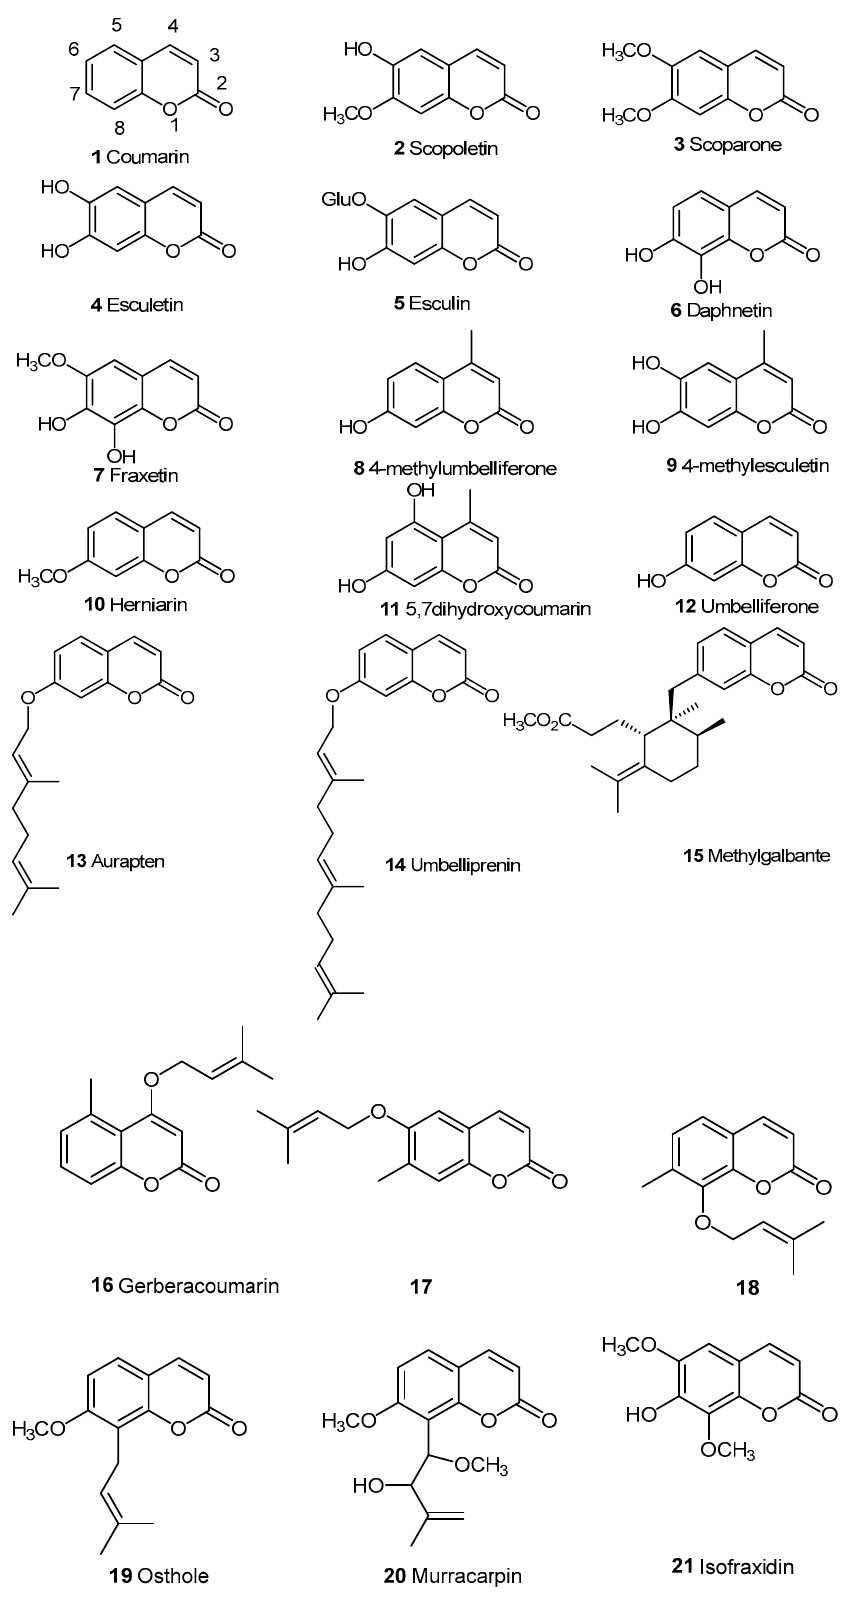
Figure 1. Natural coumarins.